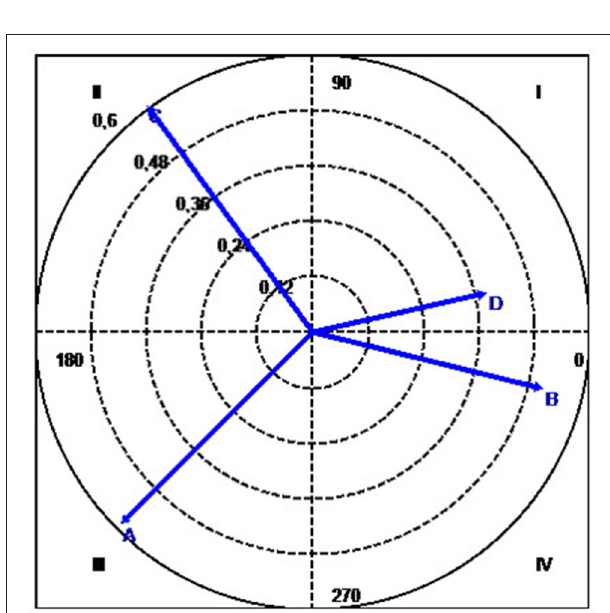
FIGURE 4 | Polar coordinate map showing the vectors for the categories A (focal category), B, C, and D. As indicated in the legend of Table 8 , A is the focal behavior and expressions of sorrow or sadness activate expressions of self-perceived improvement (Quadrant IV) and joy at having overcome the problem (Quadrant 1). The focal behavior is not self-generating (Quadrant III). Additionally, expressions of sorrow or sadness do not generate self-perceived